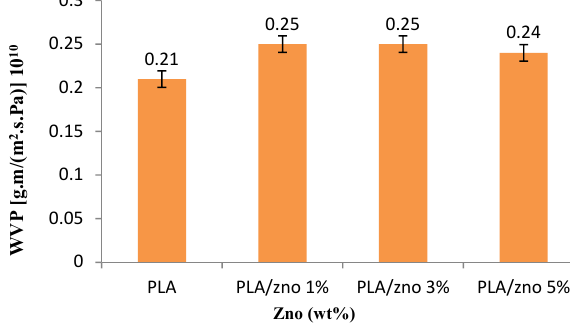
Fig. 3. Comparison of the effect of adding nano-zinc oxide with different percentages on the water vapor permeability in poly-lactic acid film